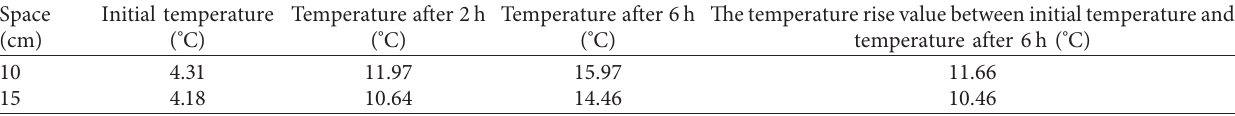
Table 9: Temperature rise value of the first layer under two space conditions. Space